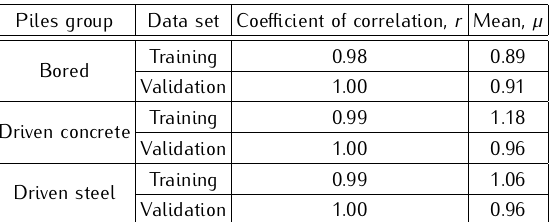
Table 4. Performance of the ANN models in the training and valida- tion sets. Piles